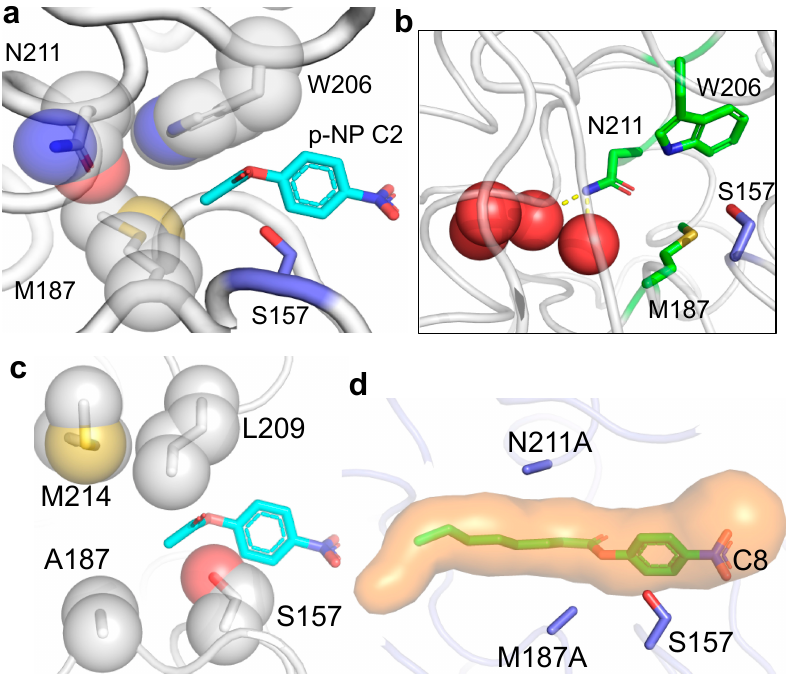
Figure 3. Structural basis for substrate binding and specificity in EstN7. The docked substrate p -NP-C2 is coloured cyan and the nucleophilic S157 is shown as blue sticks. ( a ) Docking of substrate p -NP-C2. The three residues contributing to the acyl binding pocket and the plug structure are shown as grey spheres. ( b ) The water (red spheres) cavity behind the plug. The plug residues M187, W206 and N211 are coloured green. Polar contacts from the carboxamide of N211 to the water molecules are shown as yellow dashes. The composition of the water cavity is detailed in Figure S2a. ( c ) The open plug present in PestE [30] (PDB 2YH2). ( d ) Opening the acyl pocket plug. In silico modelling of acyl plug mutations M187A mutation N211A. The accessible tunnel is coloured orange and the p -NP-C8 substrate is coloured green. The model of the M187A mutation alone is shown in Figure S2b.